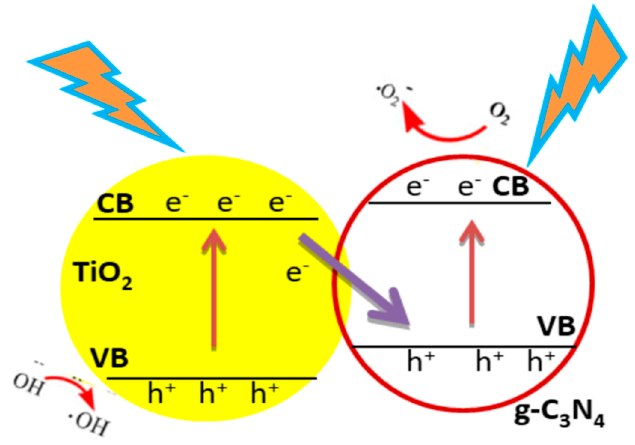
Figure 12. Illustration of Z-scheme photocatalytic mechanism for the g-C 3 N 4 .